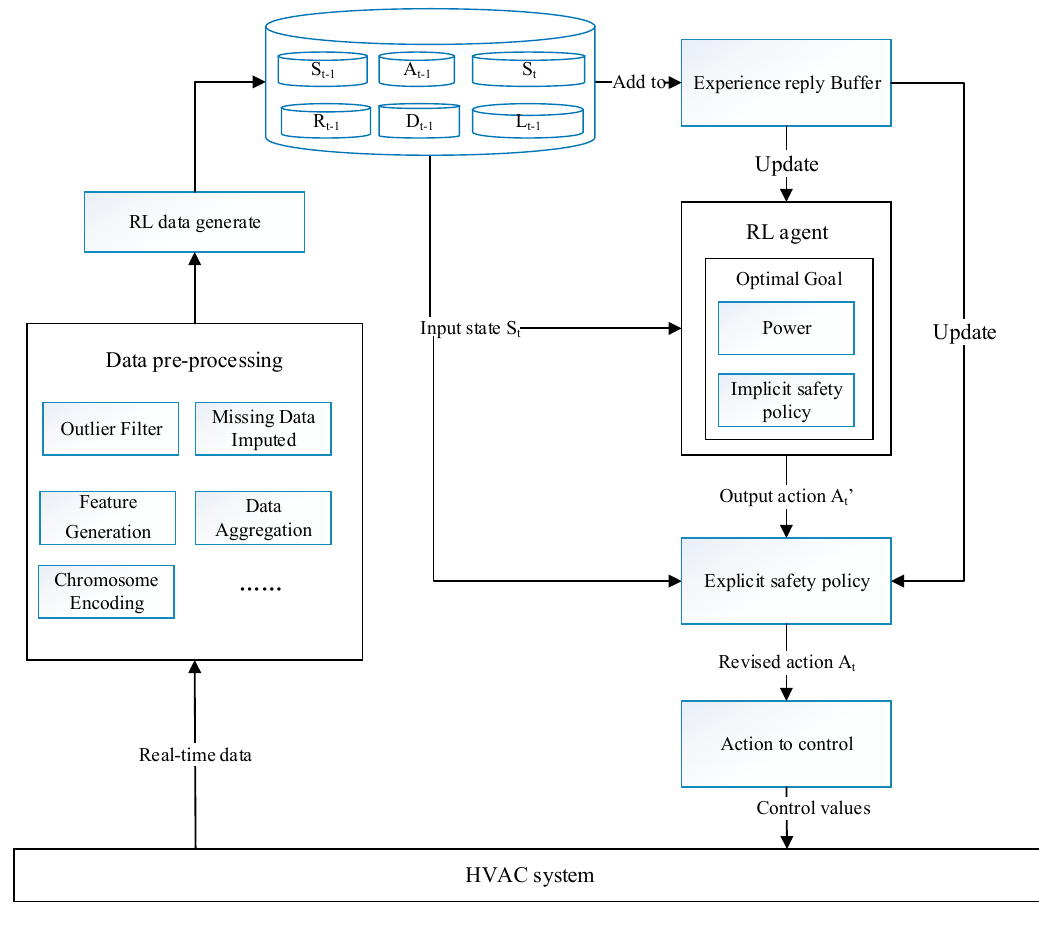
Figure 3. Schematic diagram of RL with dual safety policies.